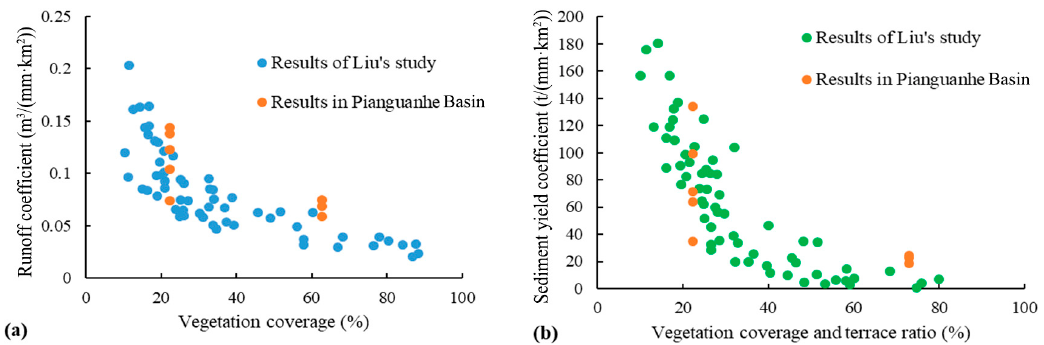
Figure 9. Comparison of runoff generation coefficient ( a ) and sediment yield coefficient ( b ) in this study and in Liu’s study.